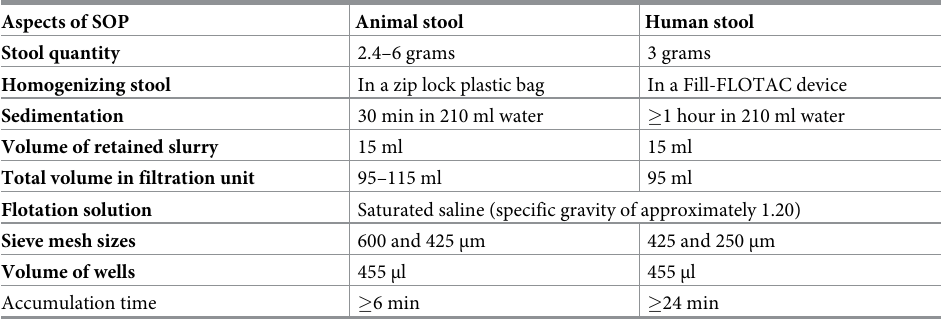
Table 1. Comparison of FECPAK G2 standard operating procedures for analyzing animal and human stool. Aspects of